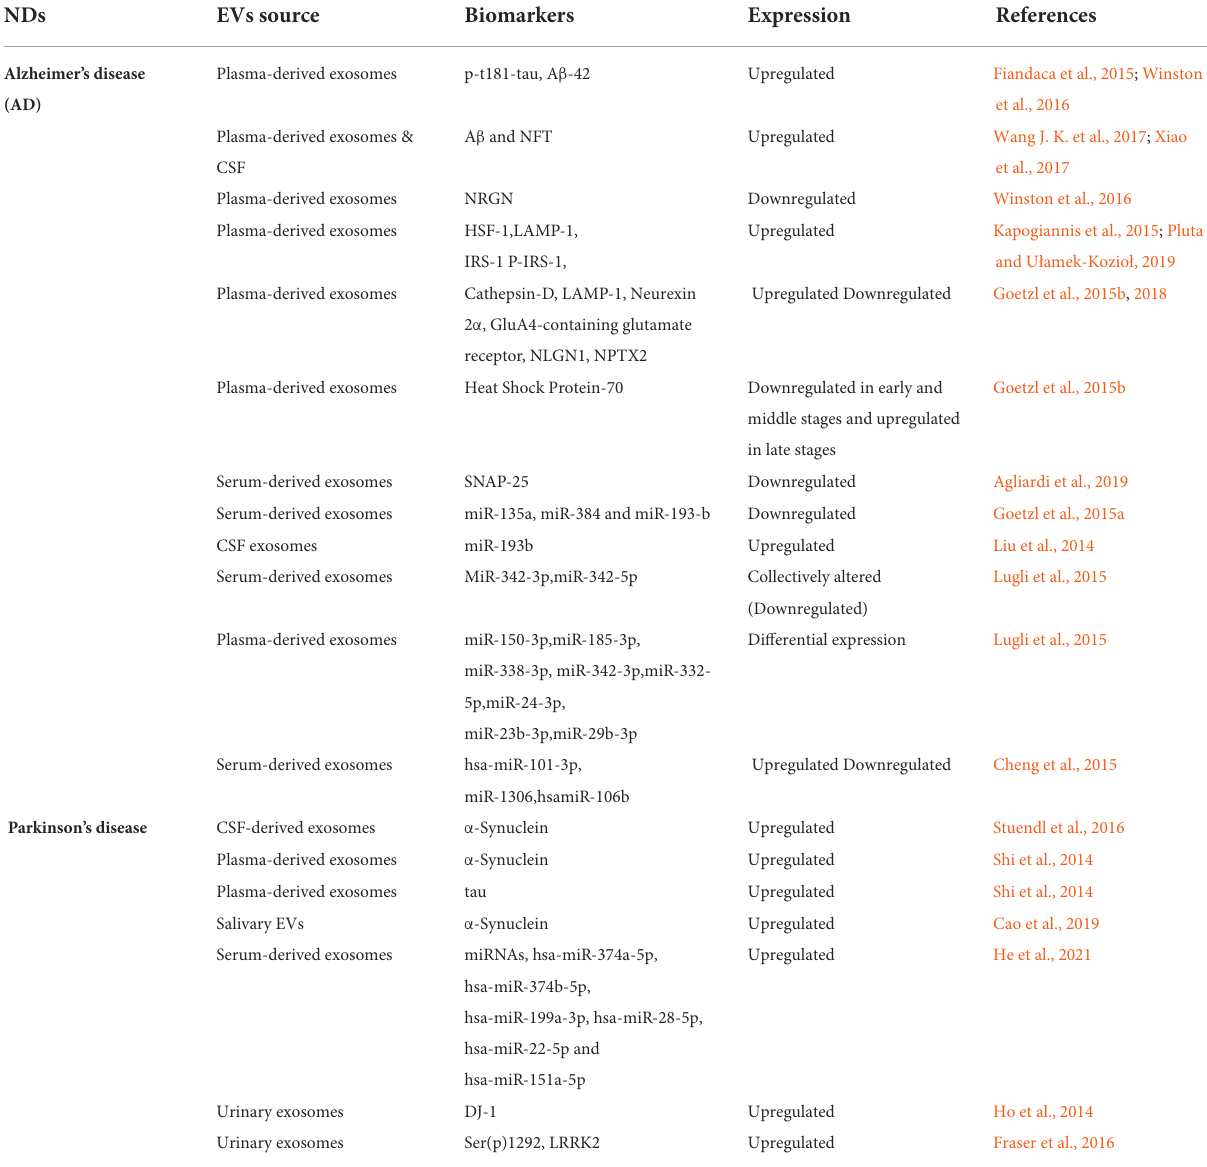
TABLE 2 The study of candidate EVs biomarkers for neurodegenerative diseases (NDs) from different